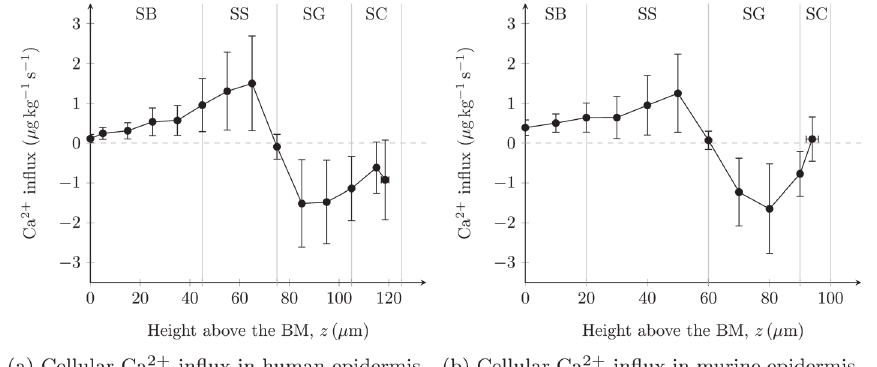
Figure 7. Keratinocyte calcium influx profiles g ( z ) in the epidermis predicted by our model. These profiles are calculated from experimental total calcium profiles reported in [26, 28].